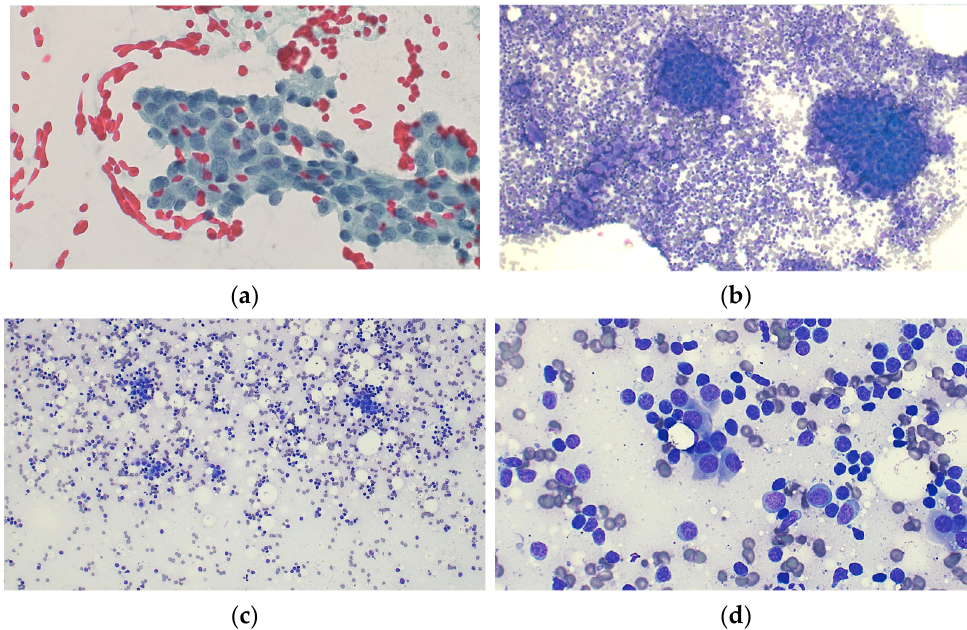
Figure 4. Examples of cytologically malignant cells as tissue fragments on high quality smears, clearly recognized in a background of lymphoid cells, consistent with metastatic carcinoma to axillary nodes. ( a ) PAP ×200 ( b ) DQ (DiffQuik, Australian Biostain P/L, Victoria, Australia) ×100 ( c ) Low power (×40) demonstrates readily identified non-lymphoid cell groups, identified as poorly cohesive and dispersed malignant cells at ( d ) higher power (×200).